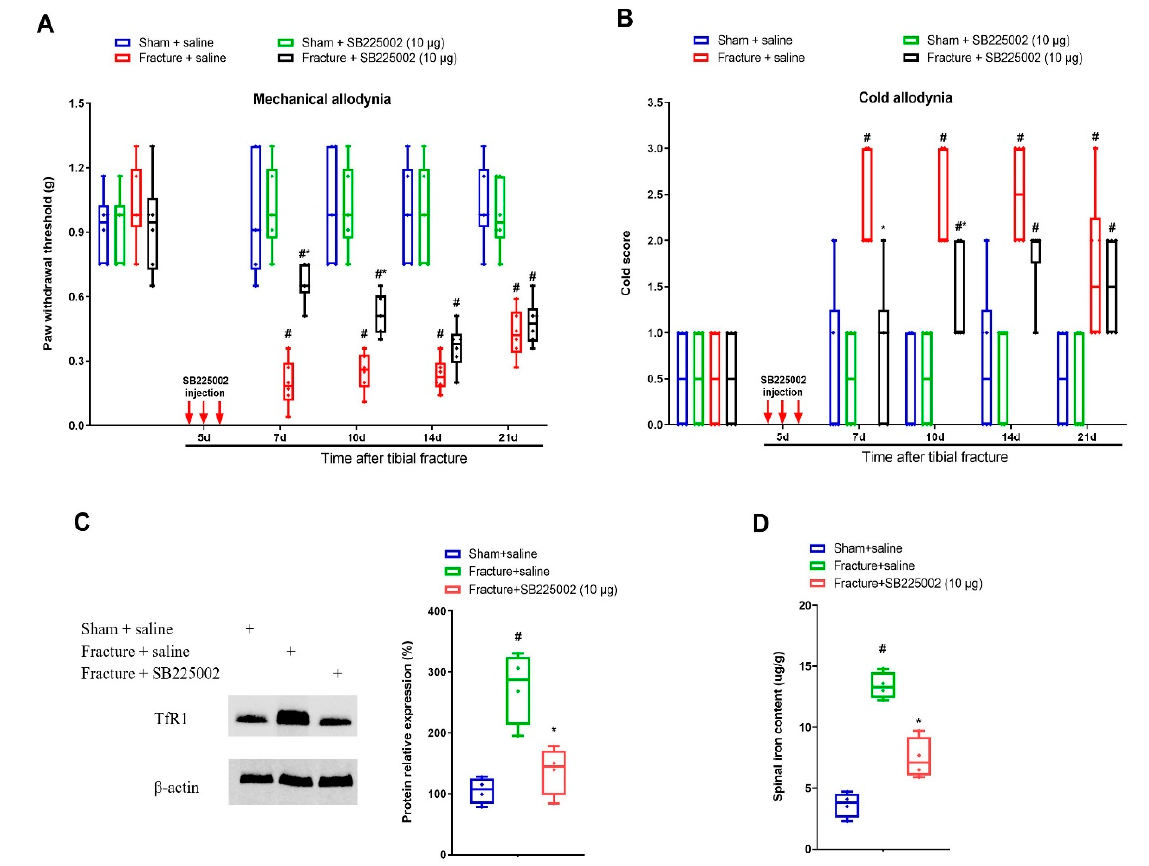
Figure 3. Spinal CXCR2 antagonism prevents fracture-caused chronic allodynia. The selective CXCR2 antagonist SB225002 (10 µ g) was intrathecally (i.t.) injected daily for 3 consecutive days on days 4, 5 and 6 (indicated by red arrows) after tibial fractures. The development of mechanical allodynia was assessed by paw withdrawal mechanical threshold ( A ) in von Frey test after fracture and SB225002 injections. The development of cold allodynia was assessed by cold response scoring ( B ) in acetone test after fracture and SB225002 injections. All behavioral data ( n = 6) are analyzed by two-way ANOVA with Bonferroni post hoc comparisons. ( C ) Spinal iron concentration on day 7 following tibial fracture and SB225002 injections was measured using atomic absorption spectrophotometer. ( D ) Western blot showed the changes of spinal TfR1 on day 7 following tibial fracture and SB225002 injections. The biochemical data ( n = 4) are analyzed by one-way ANOVA with Bonferroni post hoc comparisons. Results are expressed as medians with interquartile ranges and individual data plots. # p < 0.05 vs. group Sham + saline, * p < 0.05 vs. group Fracture + saline.